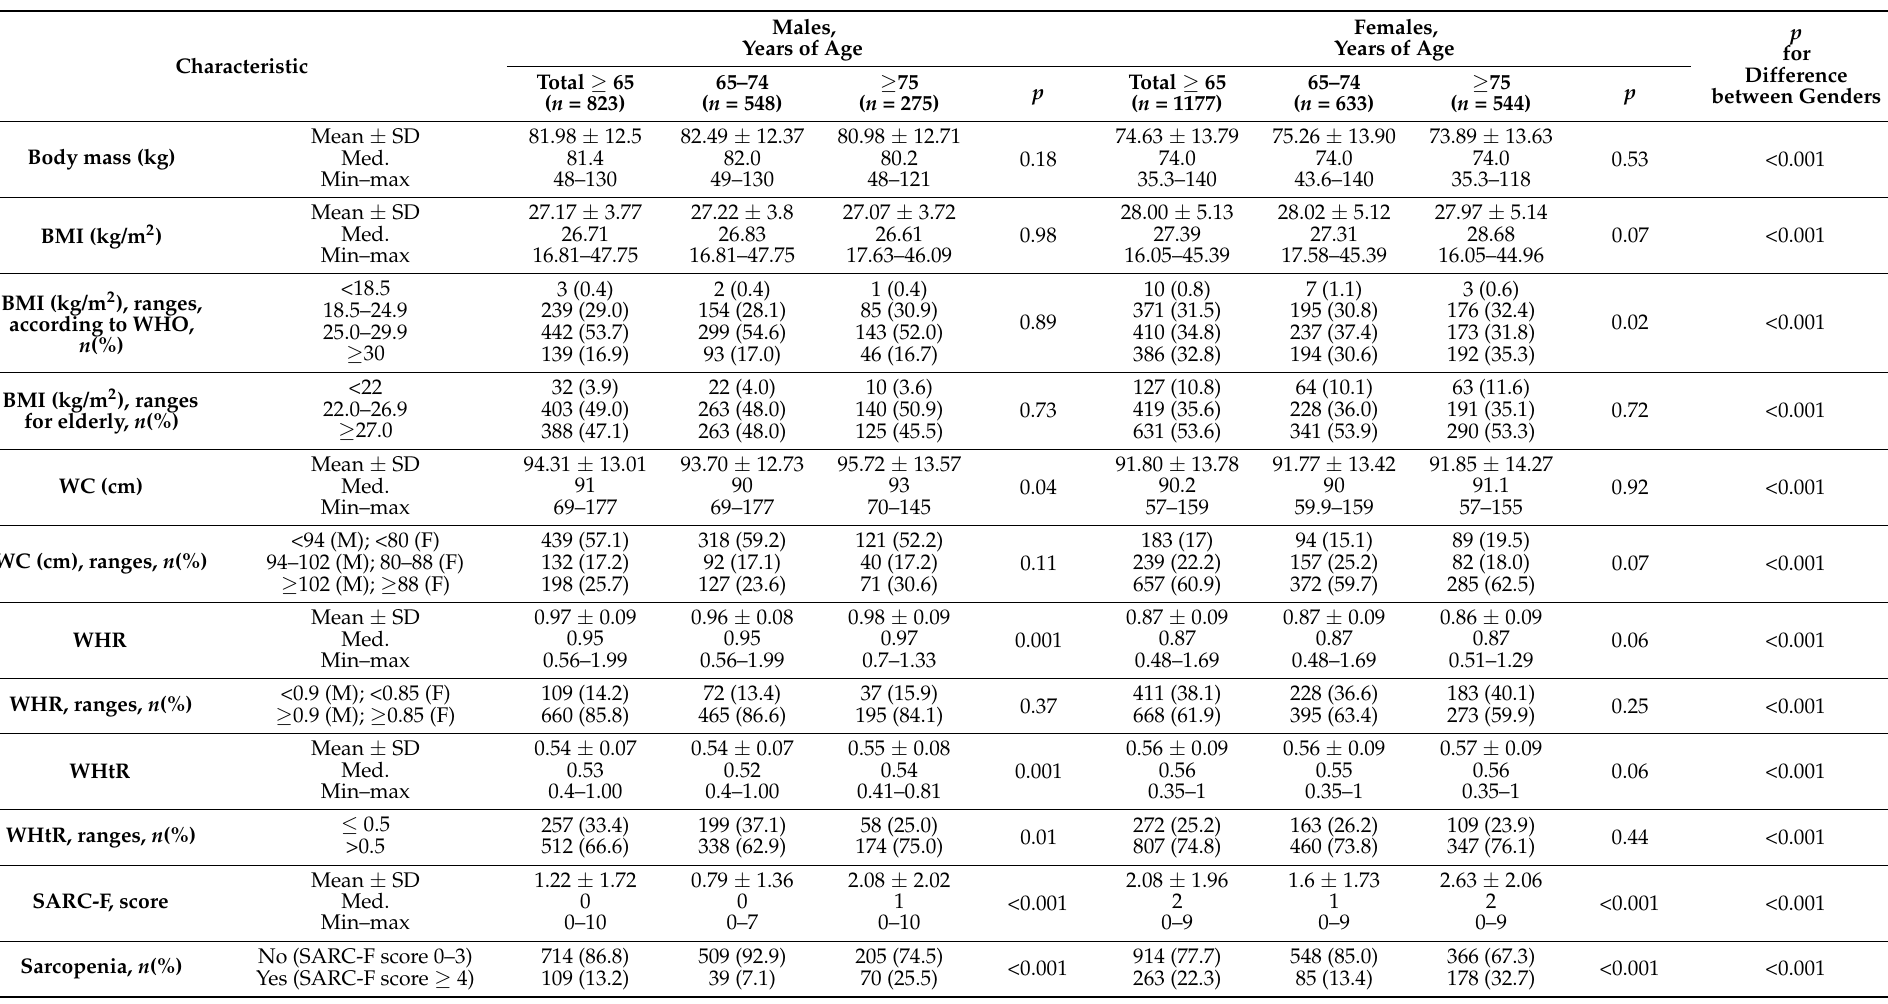
Table 2. Anthropometric characteristics and prevalence of sarcopenia risk diagnosed according to the SARC-F questionnaire in the study group, divided into age